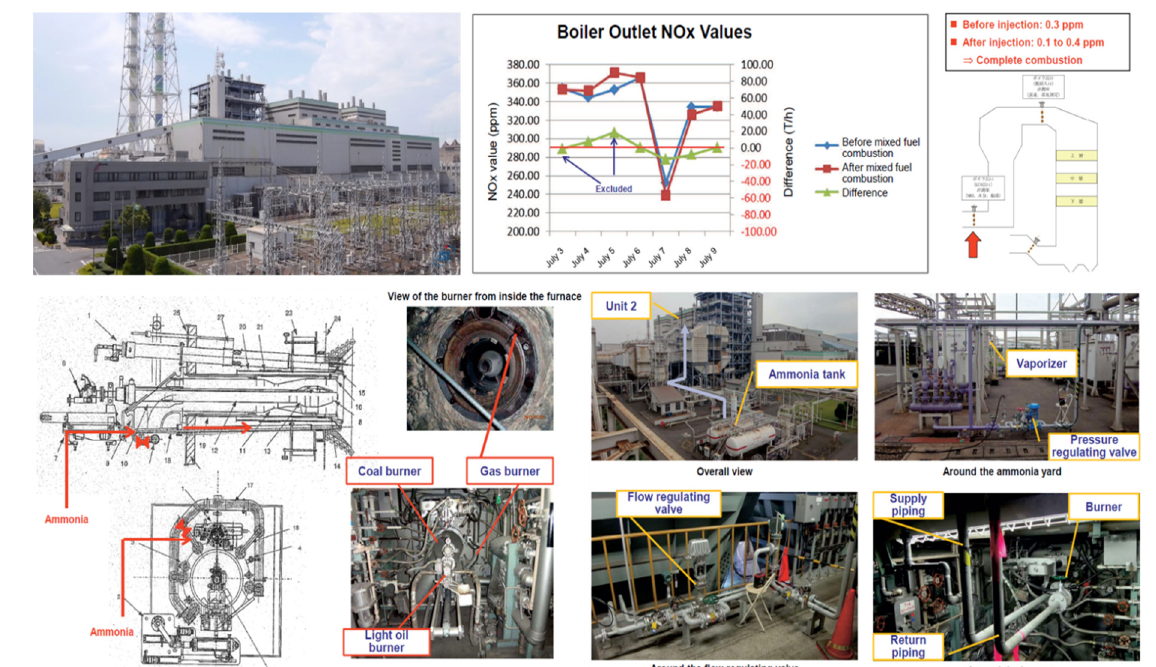
Figure 27. Burner structure and demonstration facilities in Mizushima power station unit 2. Modified from [118]. Courtesy of the Combustion Society of Japan [118].